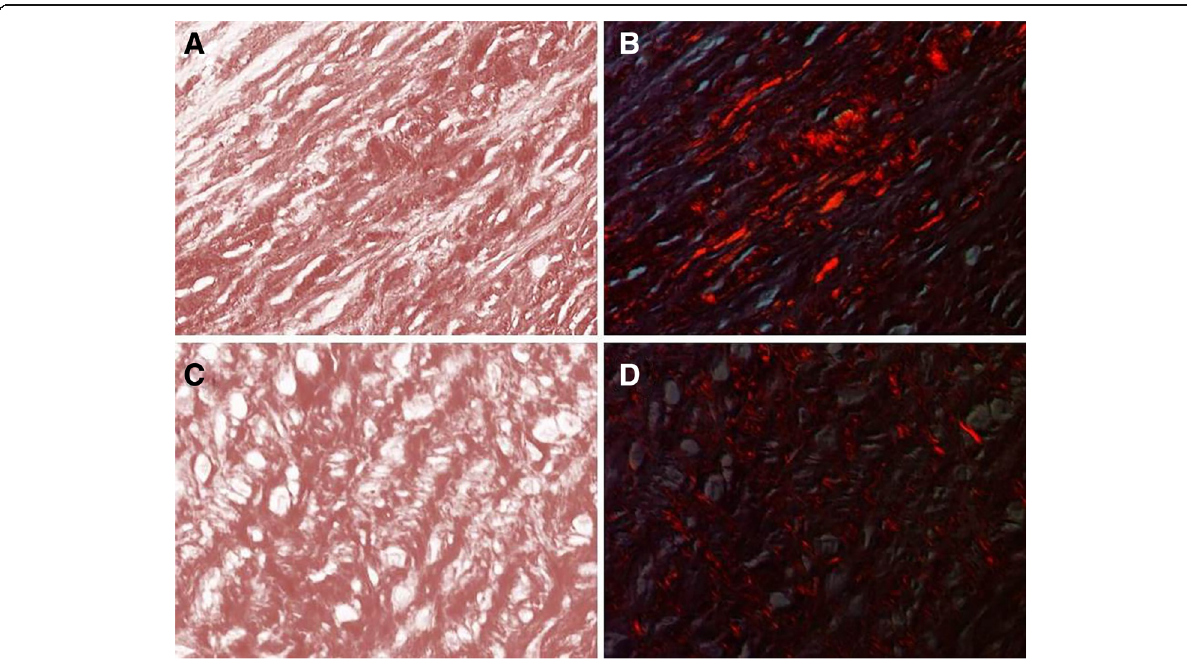
Fig. 4 a Histological section stained with picrosirius seen under common light, 1250x final increase of an elderly patient with Aids. b Histological section stained with picrosirius seen under polarized light, 1250x final increase of an elderly patient with AIDS, evidencing a greater amount of birefringent collagen fibers. c Histological section stained with picrosirius seen under common light, 1250x final increase of an elderly patient without AIDS. d Histological section stained with picrosirius seen under polarized light, 1250x final increase of an elderly patient without AIDS,